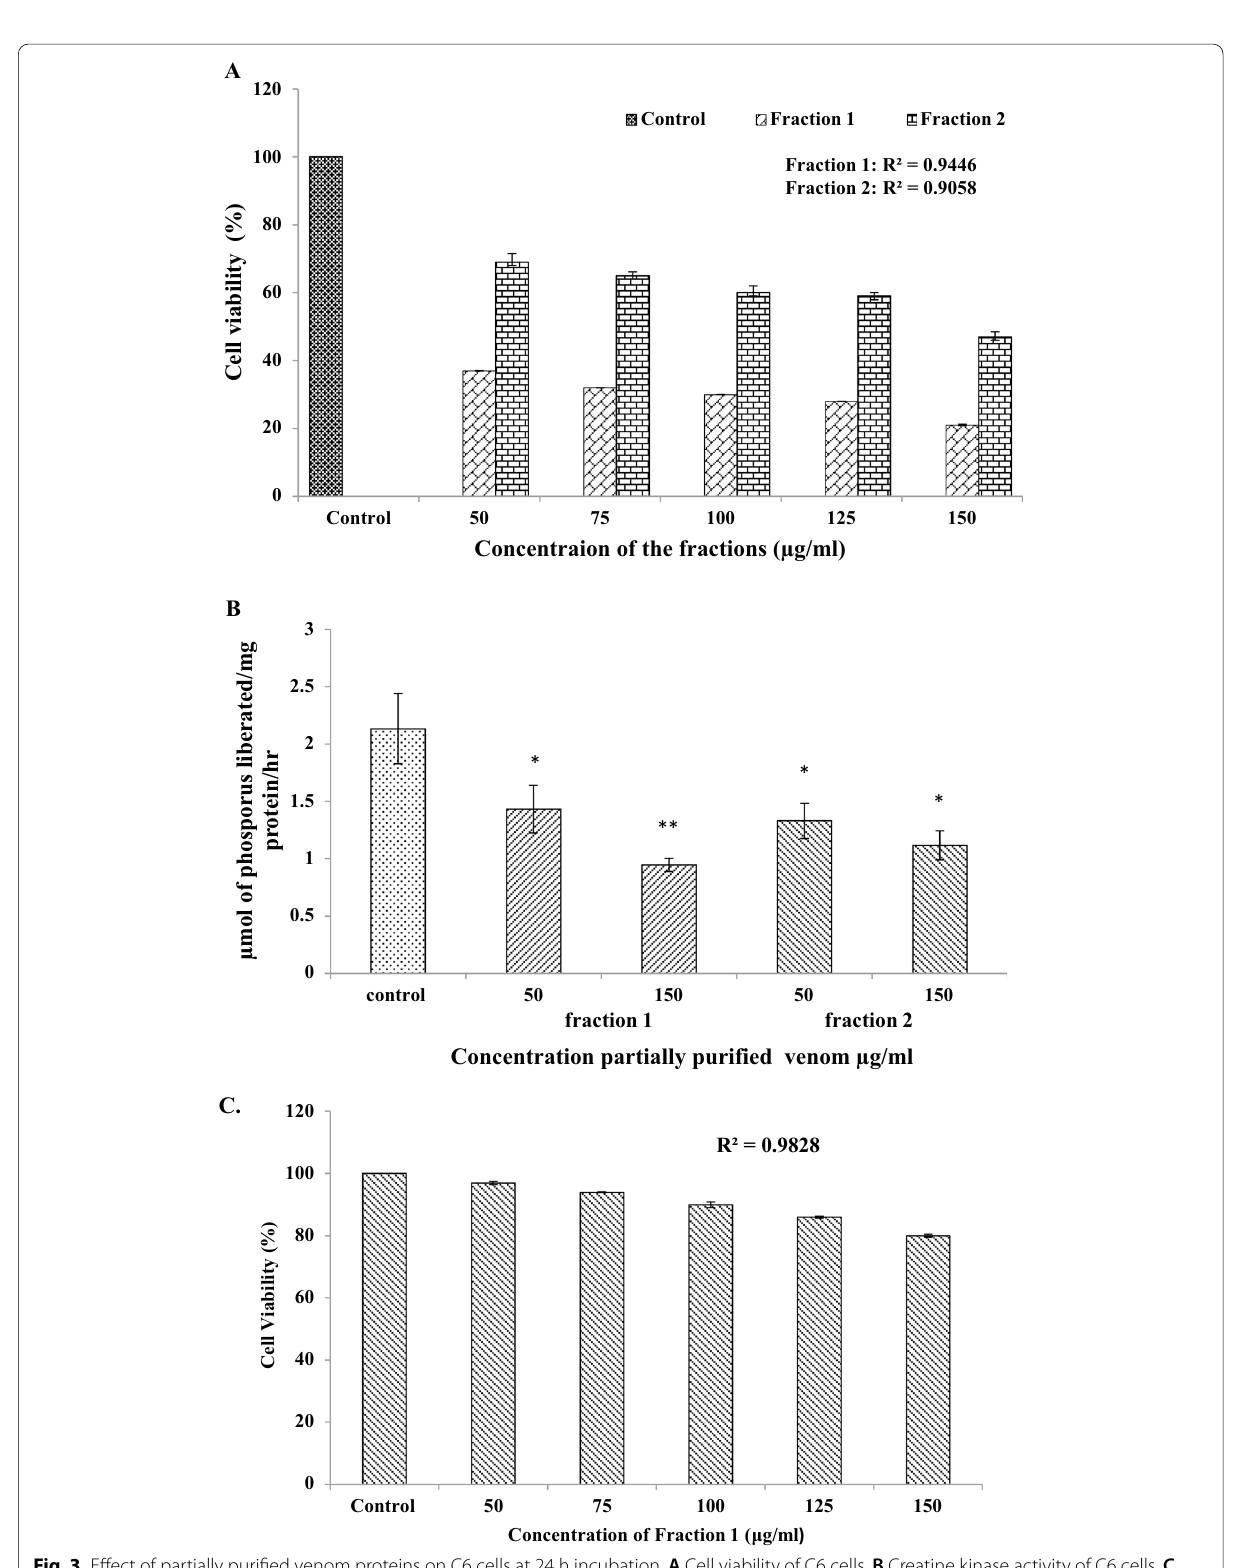
Fig. 3 Effect of partially purified venom proteins on C6 cells at 24 h incubation. A Cell viability of C6 cells. B Creatine kinase activity of C6 cells. C. Cell viability of Vero cells. Results are given as statistically significant at p ˂ 0.05 * and ˂ 0.001